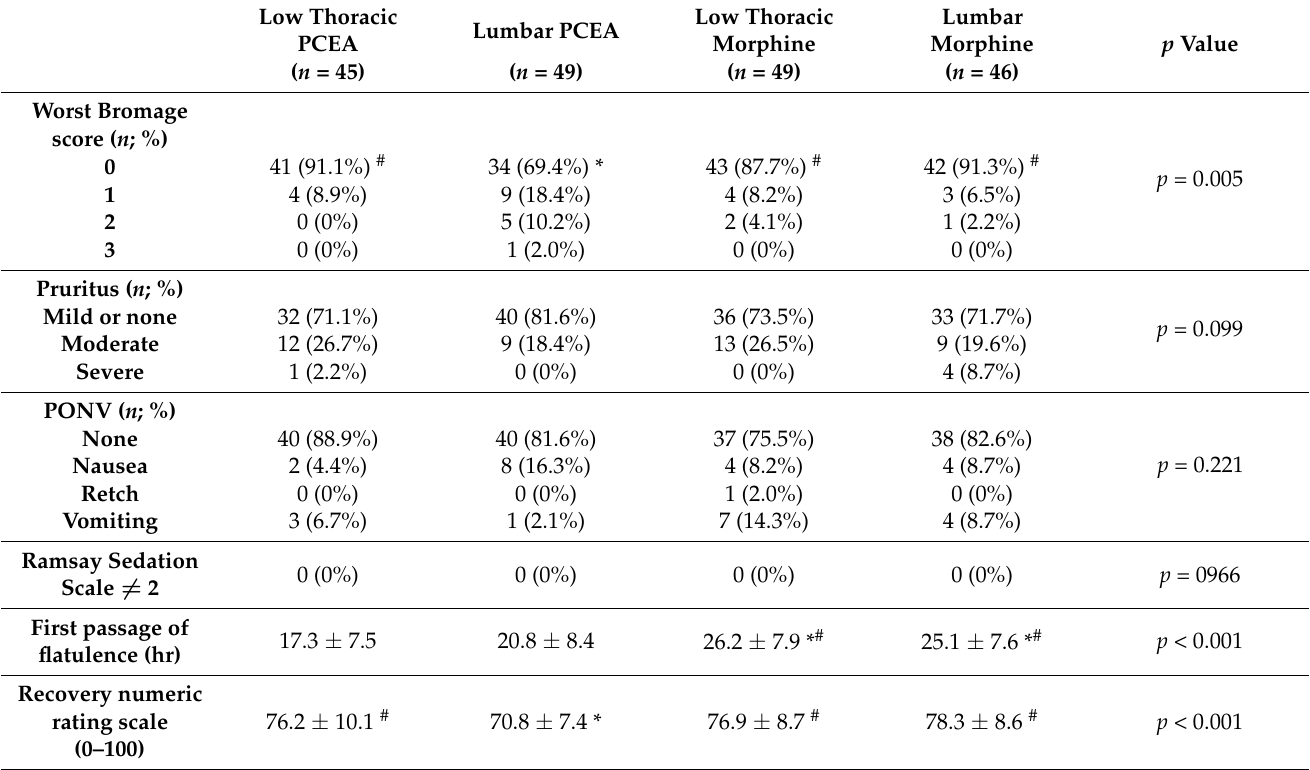
Table 3. Adverse effects